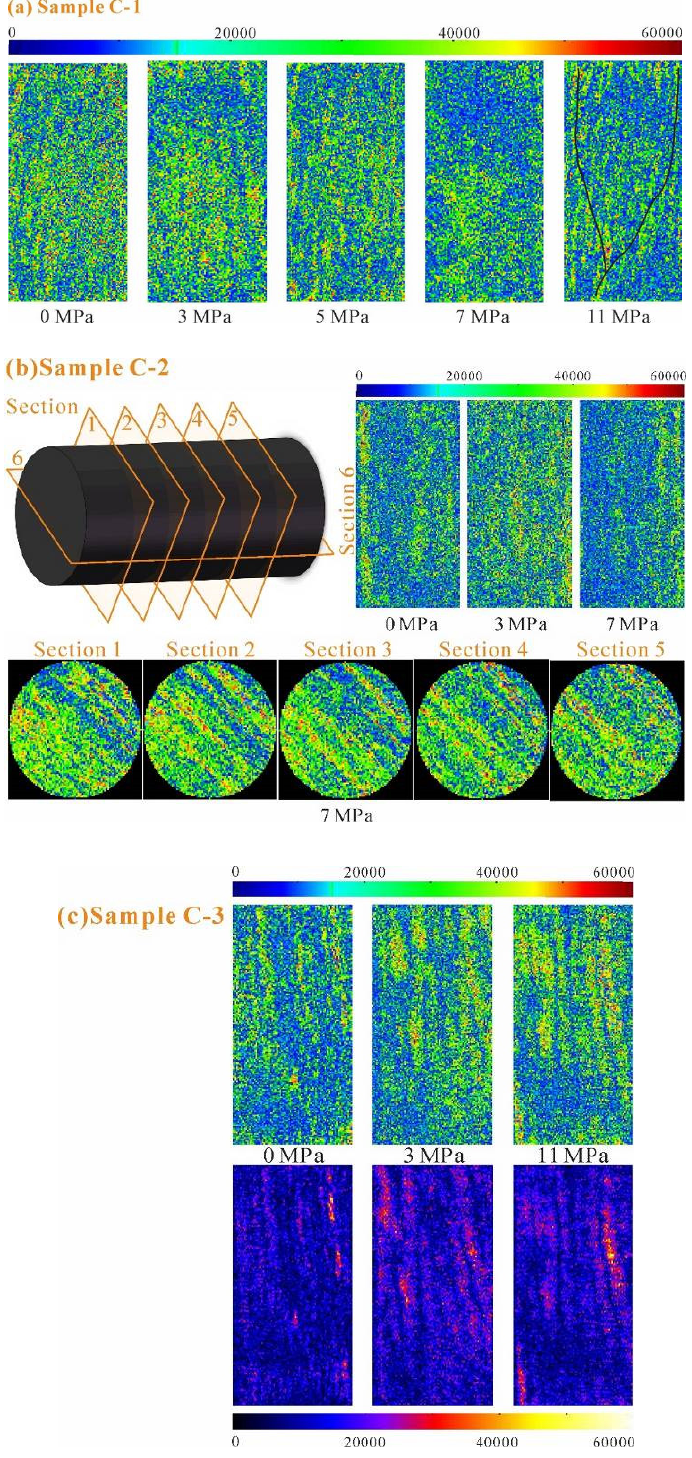
Figure 12. NMR images of the coal samples in Group C: ( a ) Sample C-1, ( b ) Sample C-2, ( c ) Sample C-3.